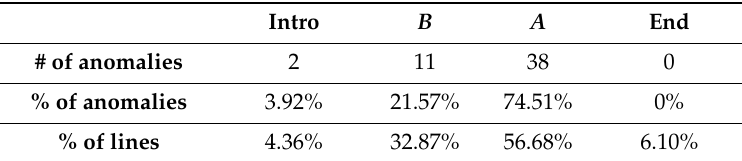
Table 6. The distribution of stylistic